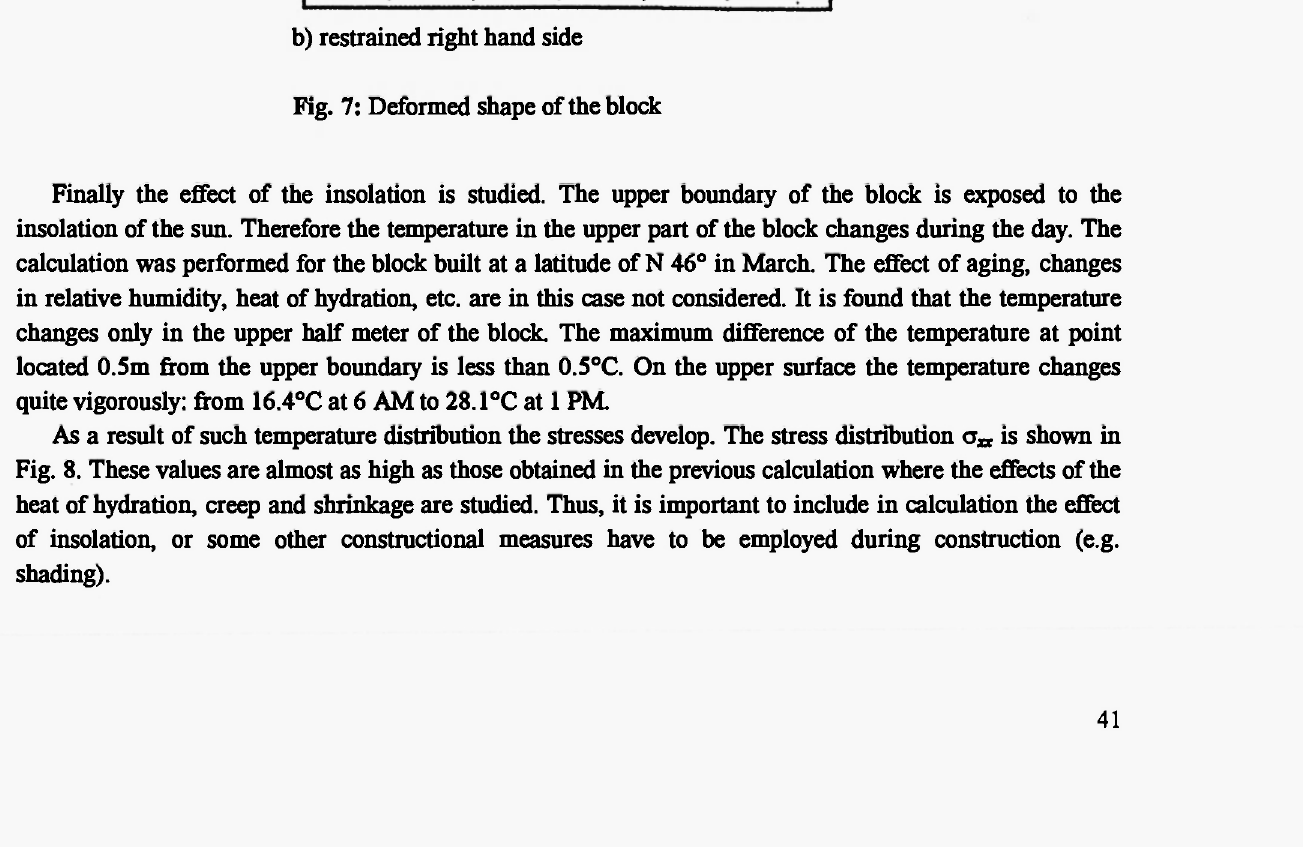
Fig. 7: Deformed shape of the